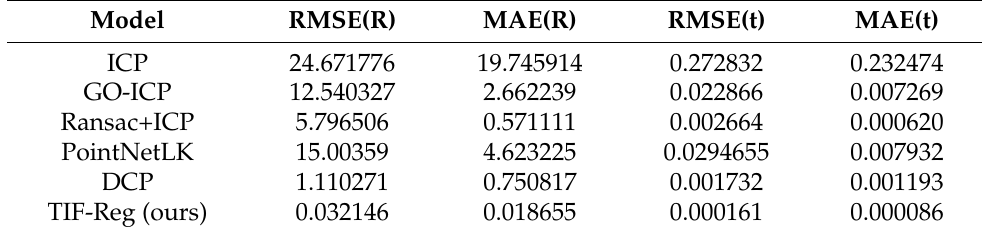
Table 1. Training and testing on same categories with ModelNet40.